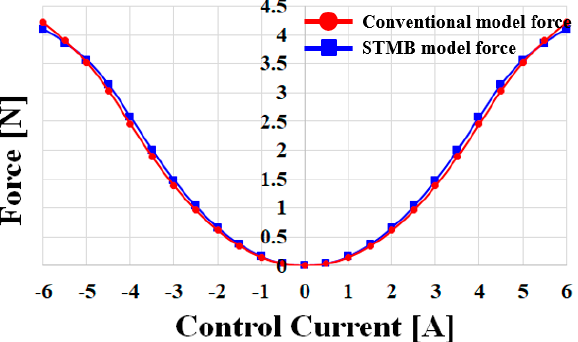
Figure 6. Magnetic force according to the control current of the existing model and the STMB.